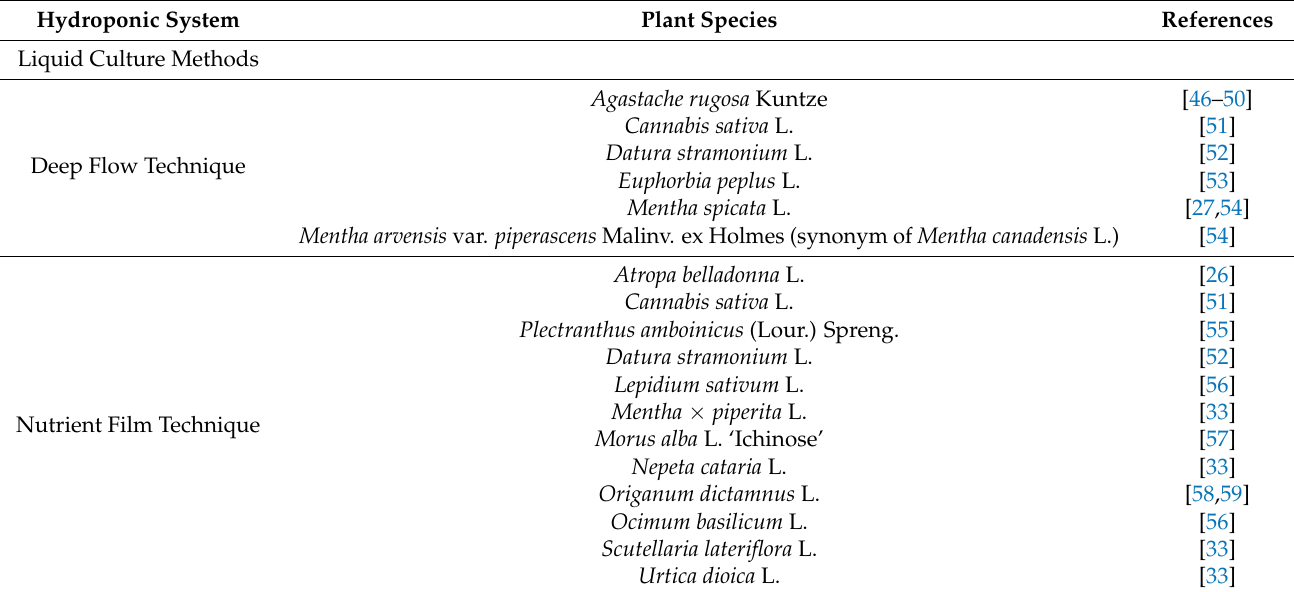
Table 1. Examples of publications discussing hydroponic cultivation of medicinal plants whose stems or leaves are